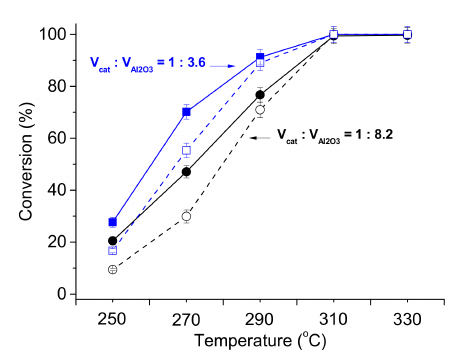
Figure 9. Effect of temperature on the conversions of methyl palmitate (solid symbols, solid lines) and oxygen-containing compounds (empty symbols, dash lines) over Ni 2 P/SiO 2 – γ -Al 2 O 3 systems with different V cat : V Al2O3 ratio. Reaction conditions: P H —3.0 MPa, H 2 /feed—600 Nm 3 /m 3 , WHSV—5 h − 1 2